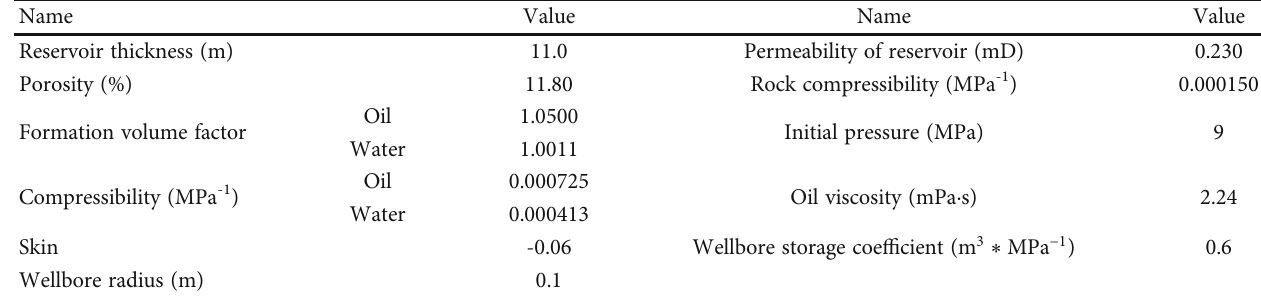
Figure 2: Production data fi t curve. Table 1: Basic reservoir